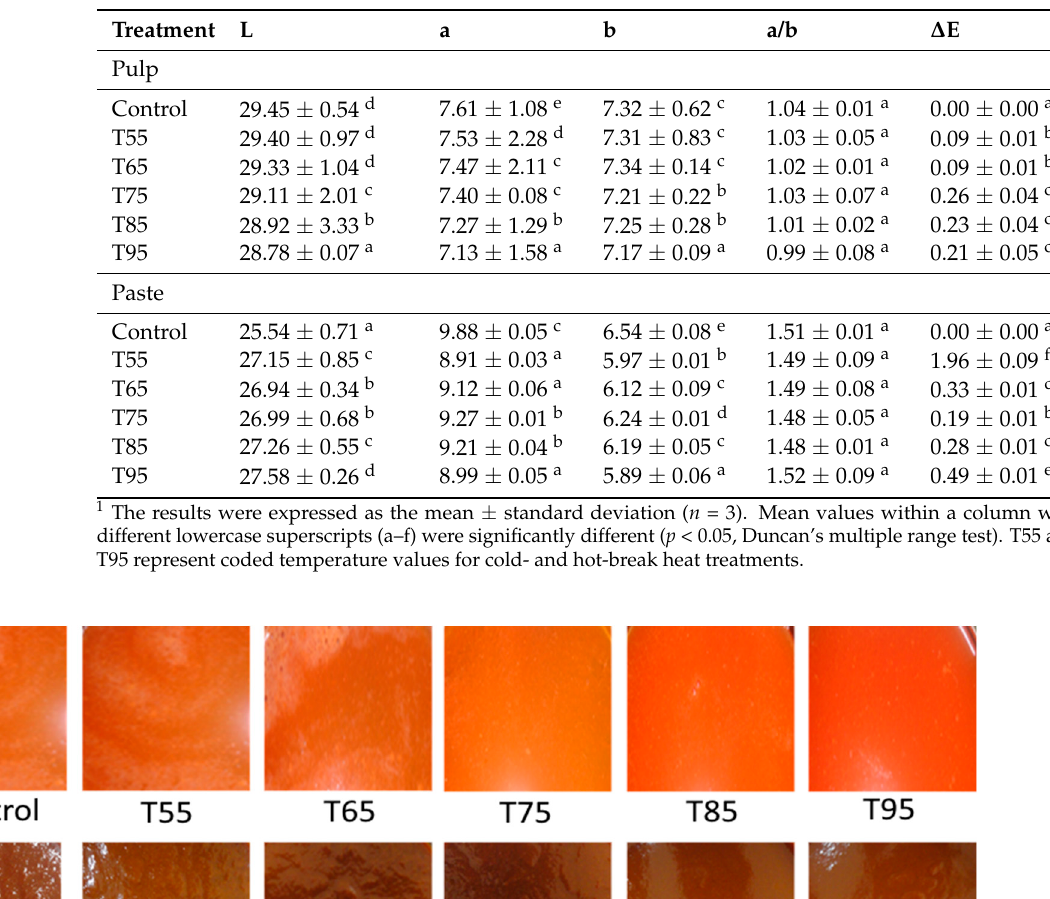
Table 2. Effect of heat treatments on the color parameters of currant tomato pulp and paste 1 .